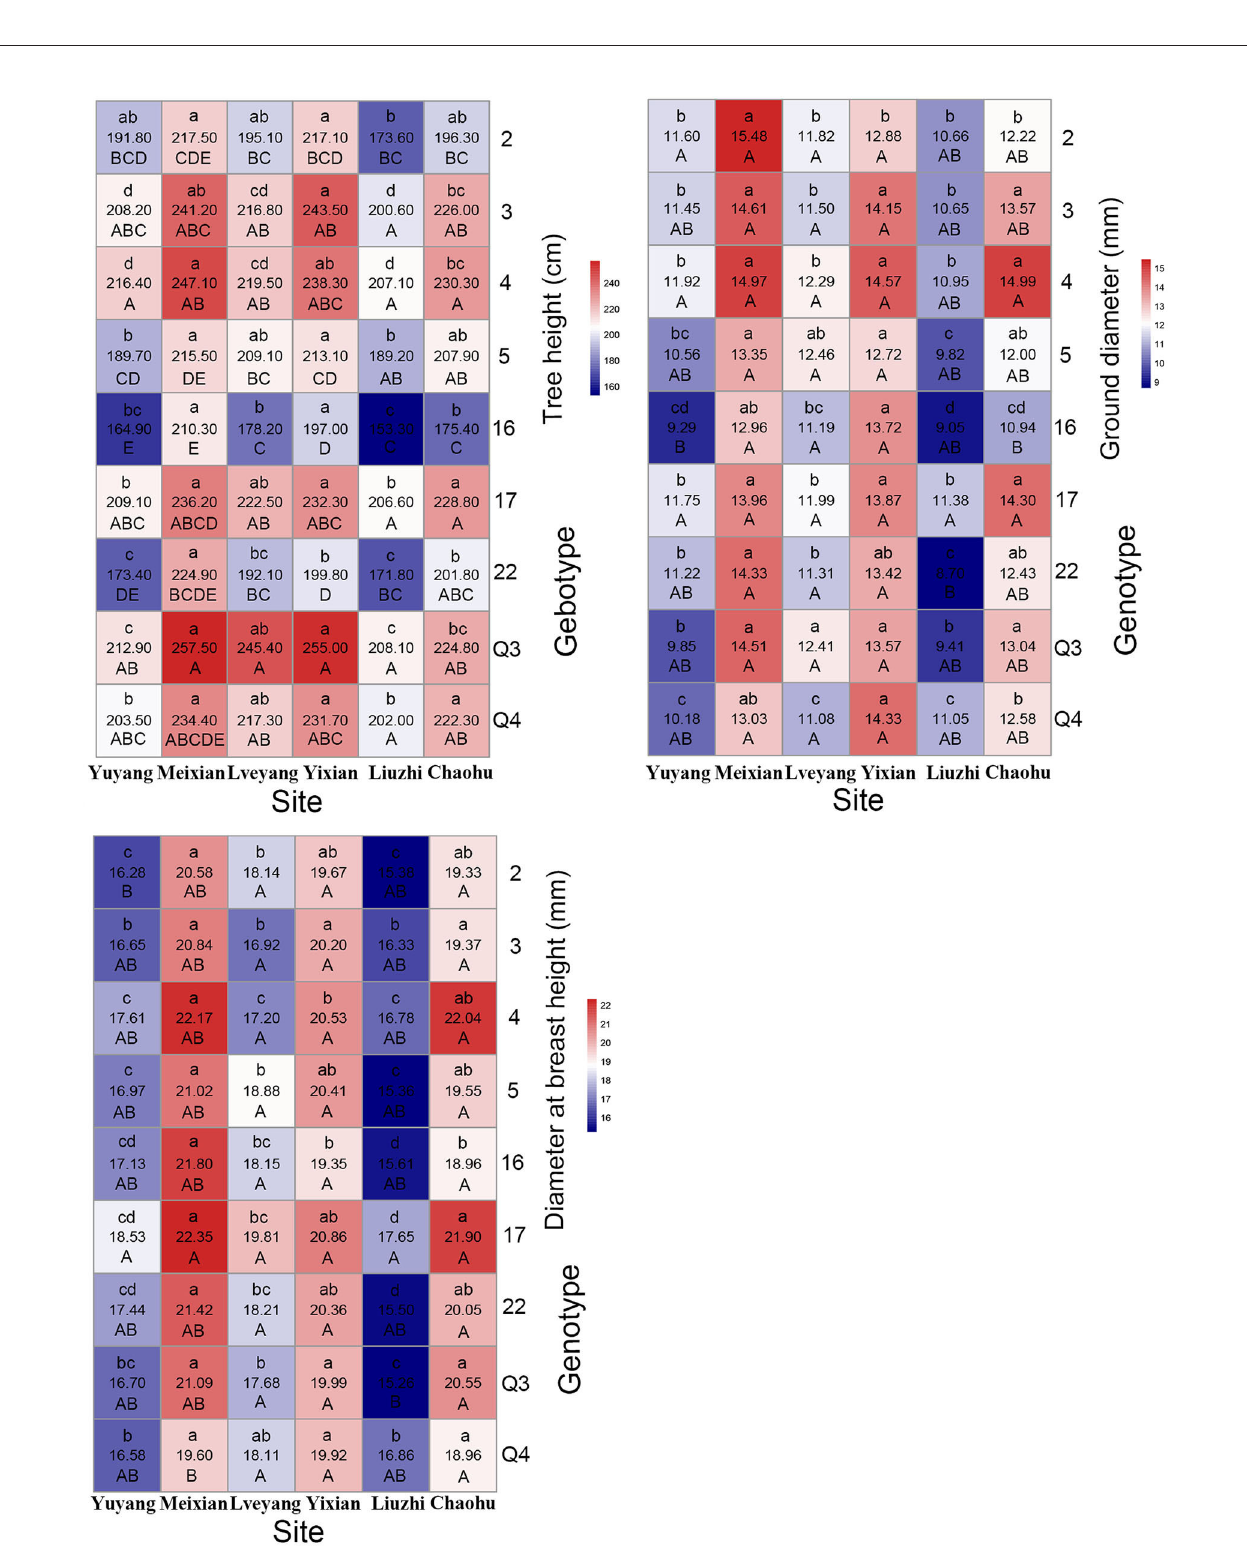
Frontiers in Plant Science |